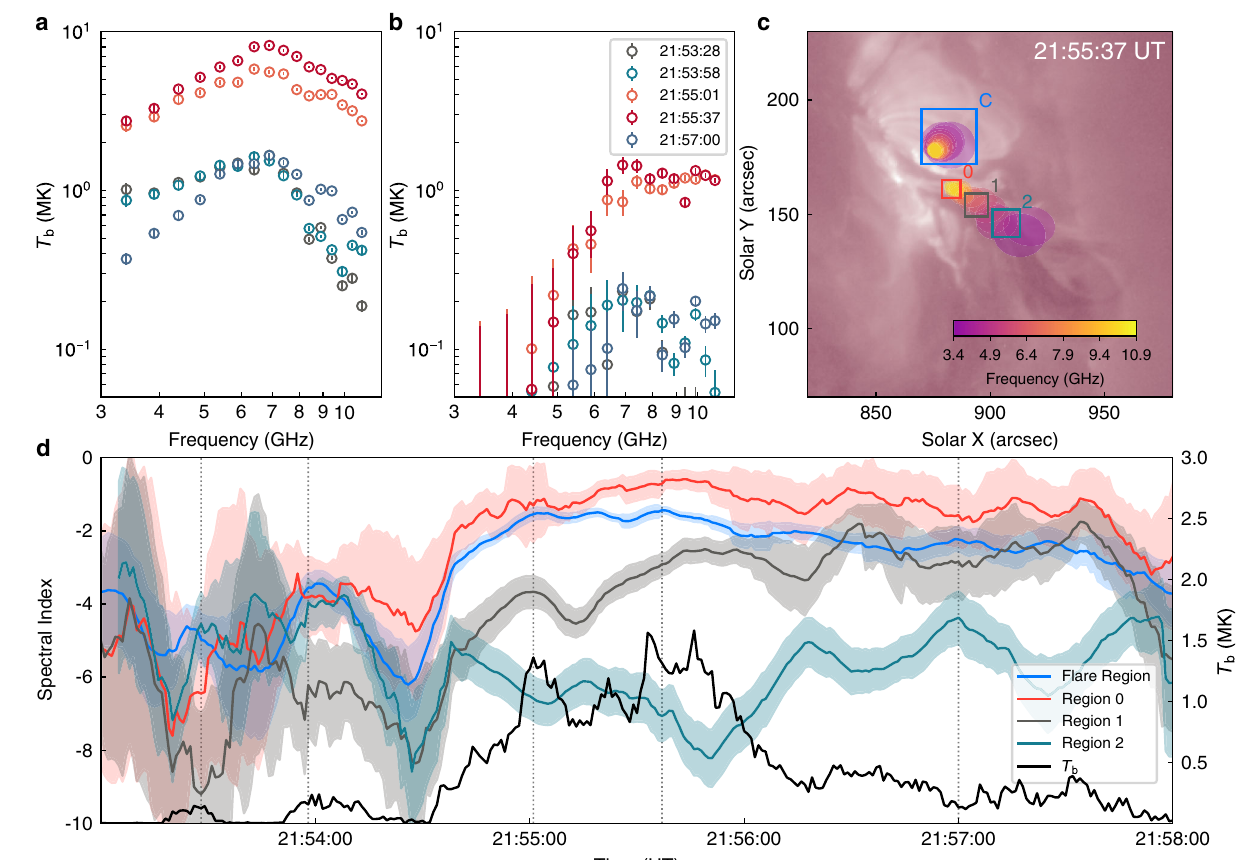
Fig. 4 | Spatially resolved microwave spectra and their temporal evolution. Microwave spectra for the fl are loops (Region C; a ) and the lower part of the CS (Region0; b )inthefrequencyrangeof3.4 – 10.9GHz.Thebrightnesstemperatures, T b , refer to maximal values in the corresponding boxes as shown in panel ( c ). The errors are the root-mean-squares of residual images, which are derived by sub- tracting two-dimensional Gaussian fi tted microwave sources from the observed ones. c The AIA 211Å image overlaid by the contours of microwave sources at